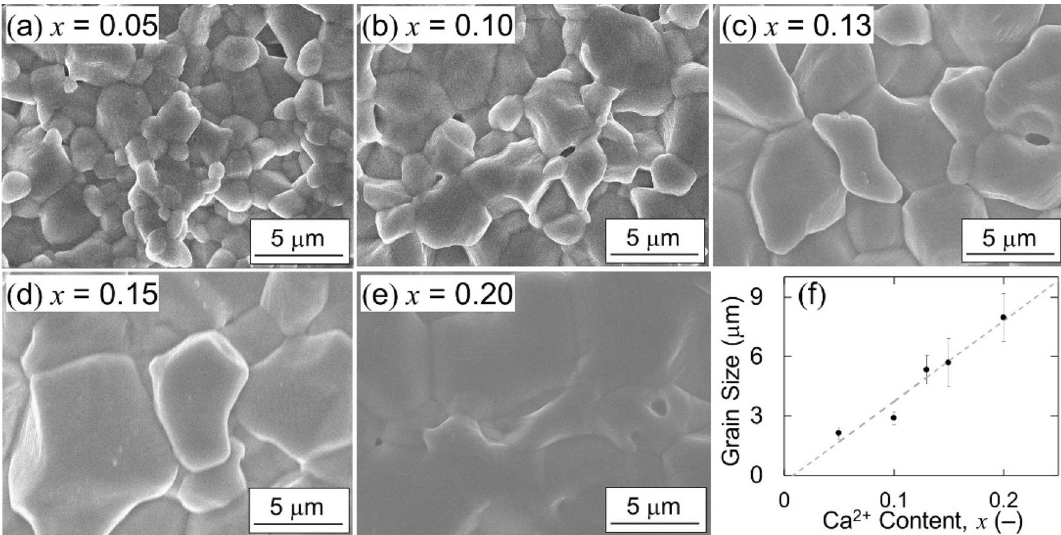
Figure 2. ( a )–( e ) Cross sectional SEM images of the Ca-modified samples with x of ( a ) 0.05, ( b ) 0.10, ( c ) 0.13, ( d ) 0.15, and ( e ) 0.20. ( f ) Composition dependence of the average grain size estimated by the intercept method using the lower magnification images shown in Fig.